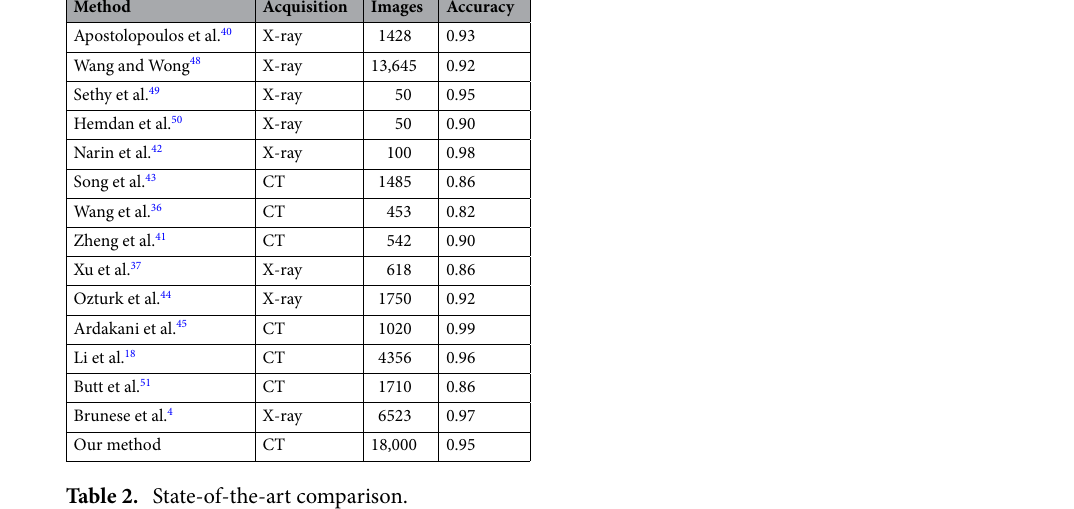
Table 2. State-of-the-art comparison.